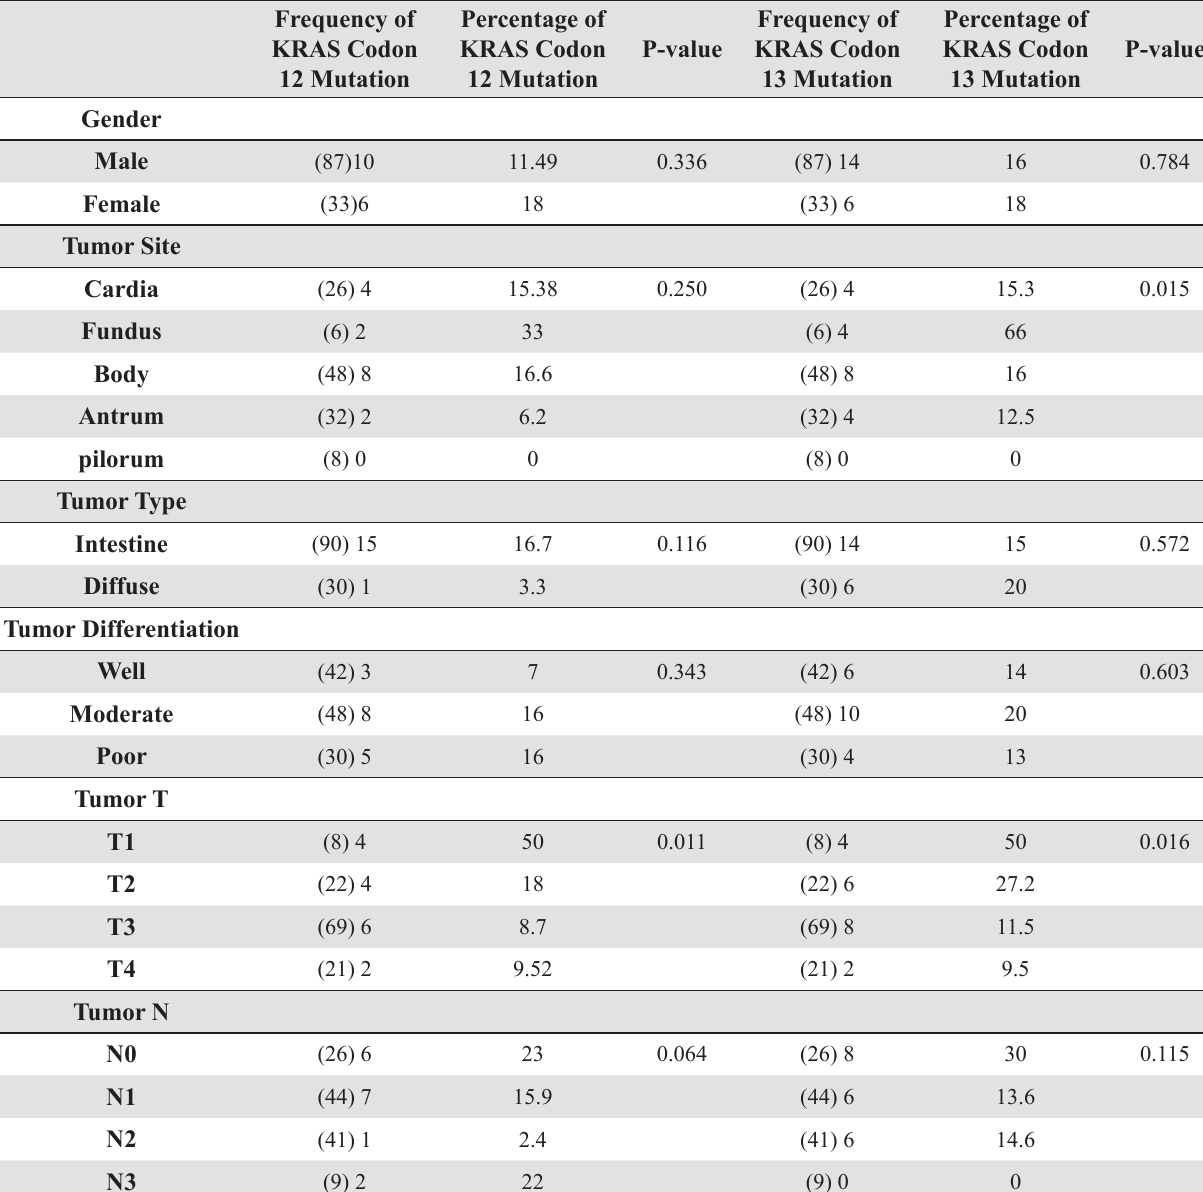
Table 1 . Relationship of KRAS Mutations With Clinical, Pathological, and Molecular Parameters of Gastric Adenocarci- noma Cases Frequency